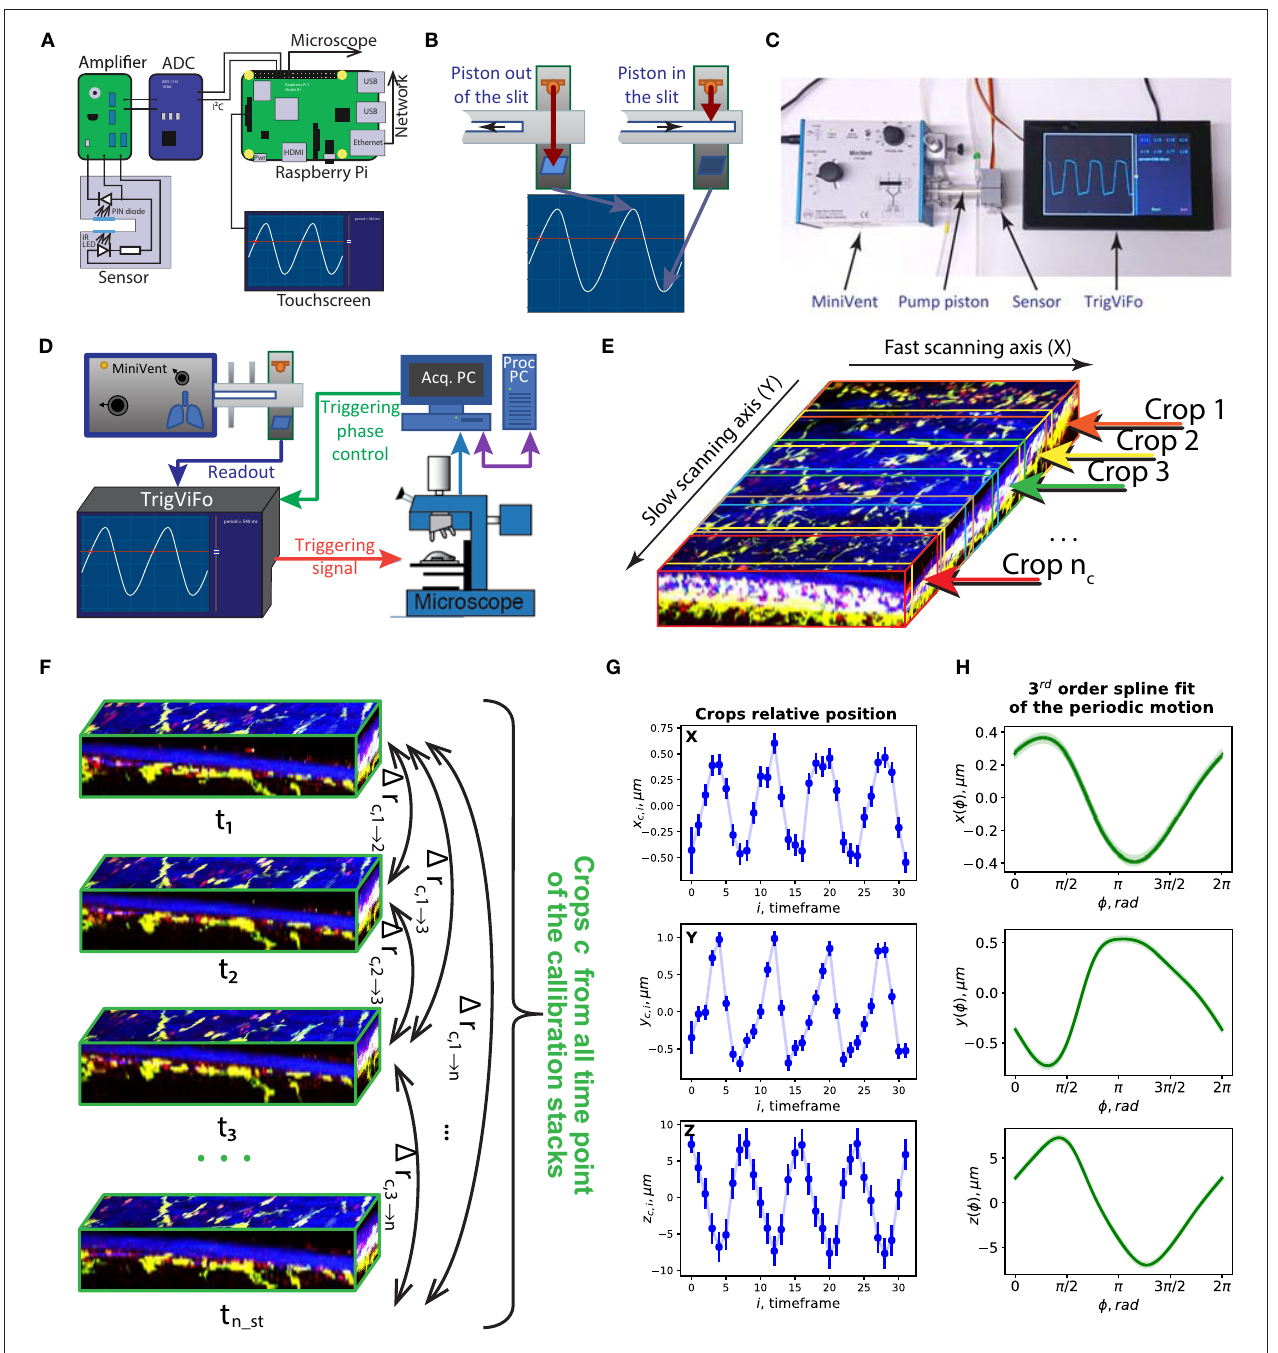
FIGURE 2 | Tissue movement profile measurement procedure in the VivoFollow 2 system. (A) Schematic representation of the TrigViFo triggering device circuit. (B) A slotted sensor composed of an infrared LED and a PIN photodiode is used for synchronization of the image acquisition with the piston movement of the ventilator. (C) The sensor is attached to the pump of the MiniVent ventilator and connected to TrigViFo. (D) Imaging setup. (E–H) . Distortion mapping procedure. (E) Image volume is split into overlapping crops along the slow scanning axis. (F) Pairwise offsets are found between all time points of calibration stacks for each crop. (G) Relative position of crops at all time points is found by global solving. (H) Spline fit of the periodic tissue motion after pooling all crops